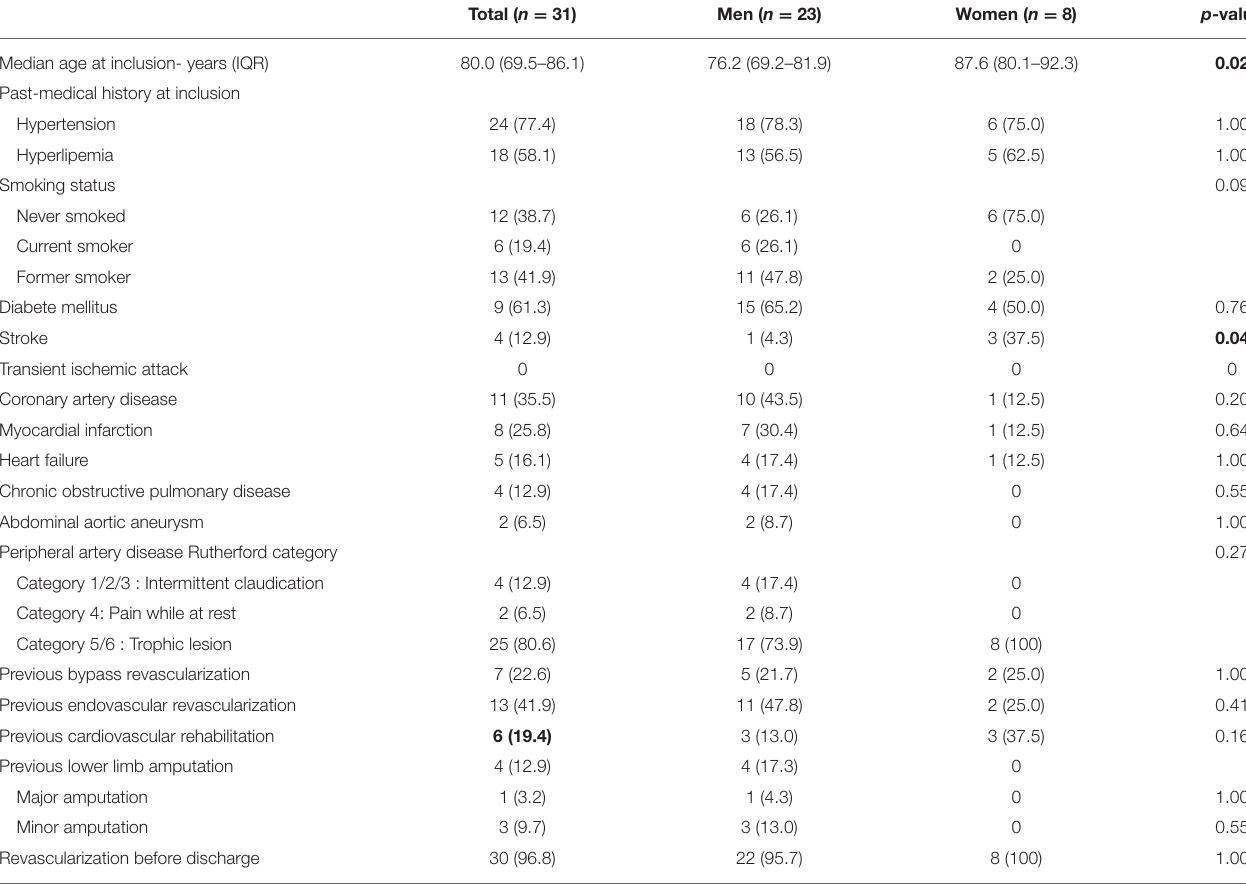
TABLE 3 | Baseline characteristics of patients dead within 1 year and sex comparison. Total ( n = 31) Men ( n = 23) Women ( n = 8) p -value Median age at inclusion- years (IQR) 80.0